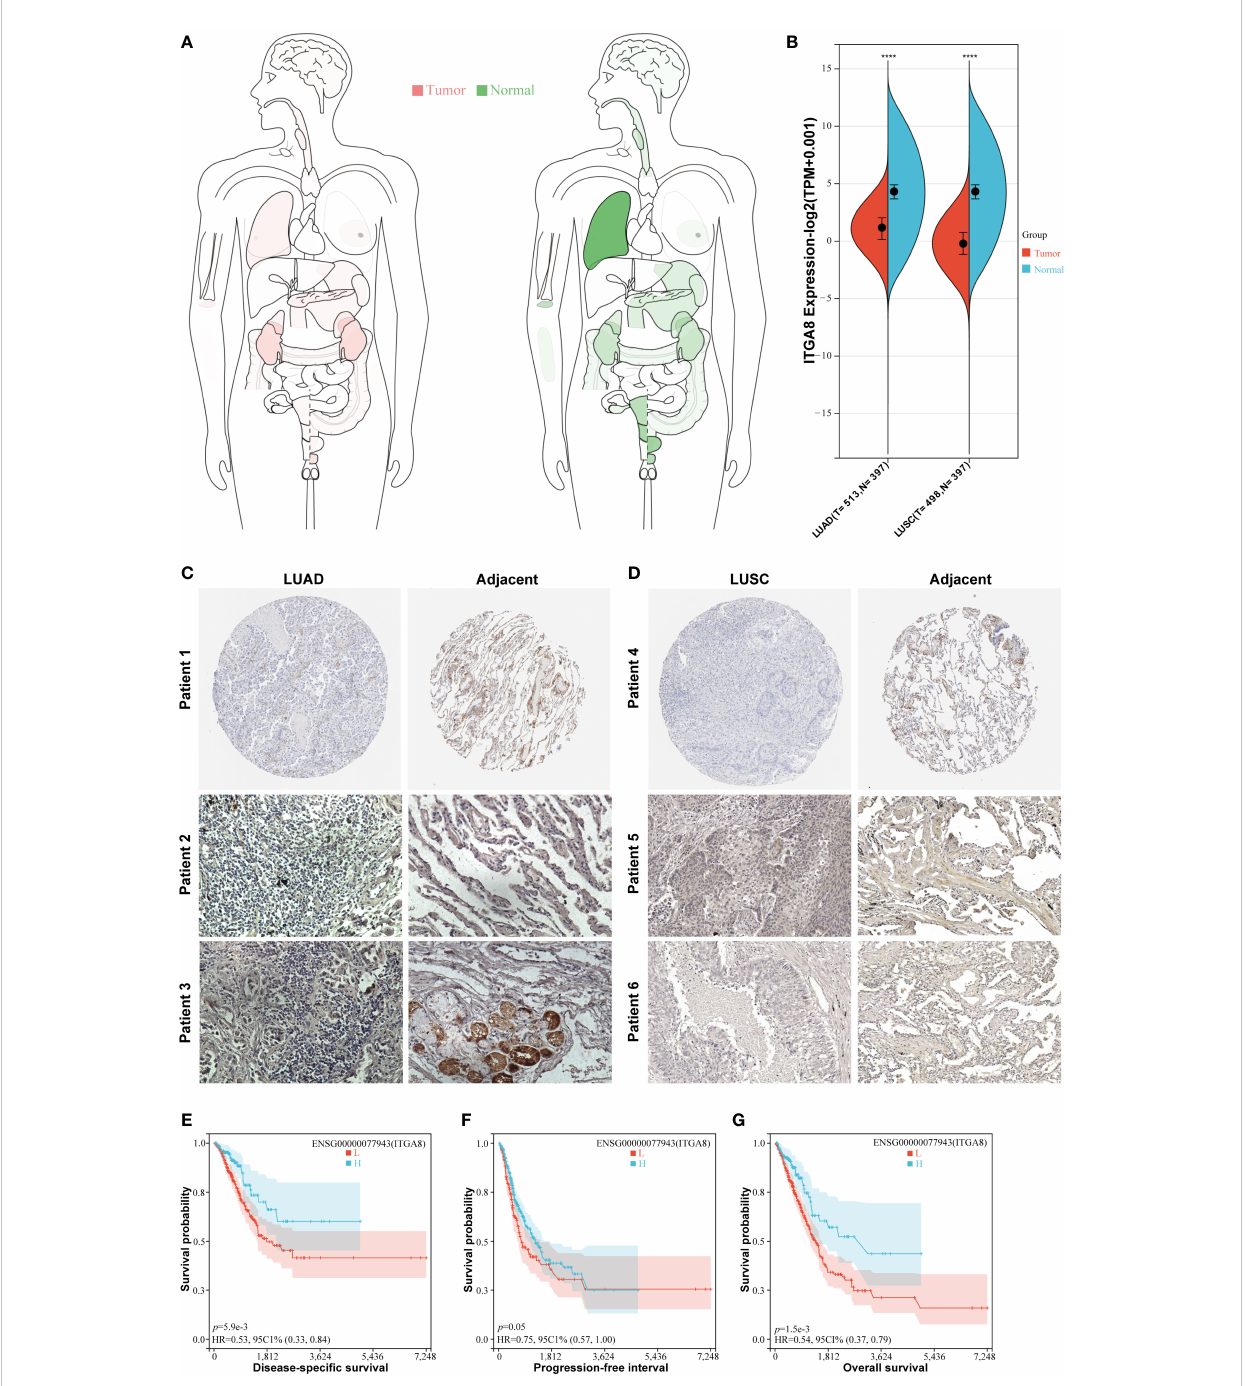
FIGURE 1 ITGA8 expression in non-small cell lung cancer (NSCLC) tissues and normal lung tissues and the prognostic value of ITGA8 in patients with LUAD. (A) ITGA8 gene expression data were acquired from TCGA and the body map of the median expression level of the ITGA8 gene in tumor and normal organs is shown. (B) The ITGA8 gene expression data were acquired from TCGA and the box diagram of ITGA8 expression in LUAD, LUSC, and matched normal lung tissues is shown. The expression level of ITGA8 gene was marked as Log 2(TPM+0.001) Scale. (C, D) The ITGA8 protein expression data of LUAD, LUSC, and matched normal lung tissues are shown. The data of patients 1 and 4 were downloaded from the Human Protein Atlas. The data of patients 2, 3, 5, and 6 were from our department. The patients with LUAD were divided into the high and low expression groups according to ITGA8 expression and Kaplan – Meier survival analysis was performed for (E) disease-speci fi c survival ( p = 0.0059), (F) progression-free interval ( p = 0.05) and (G) overall survival ( p = 0.0015). **** p <